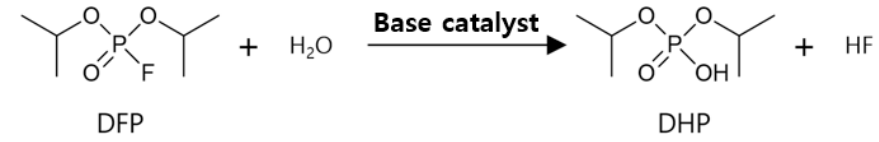
Figure 1. Figure 1. Base-catalyzed hydrolysis of diisopropylfluorophosphate (DFP) to diisopropylhydrogenphosphate (DHP).